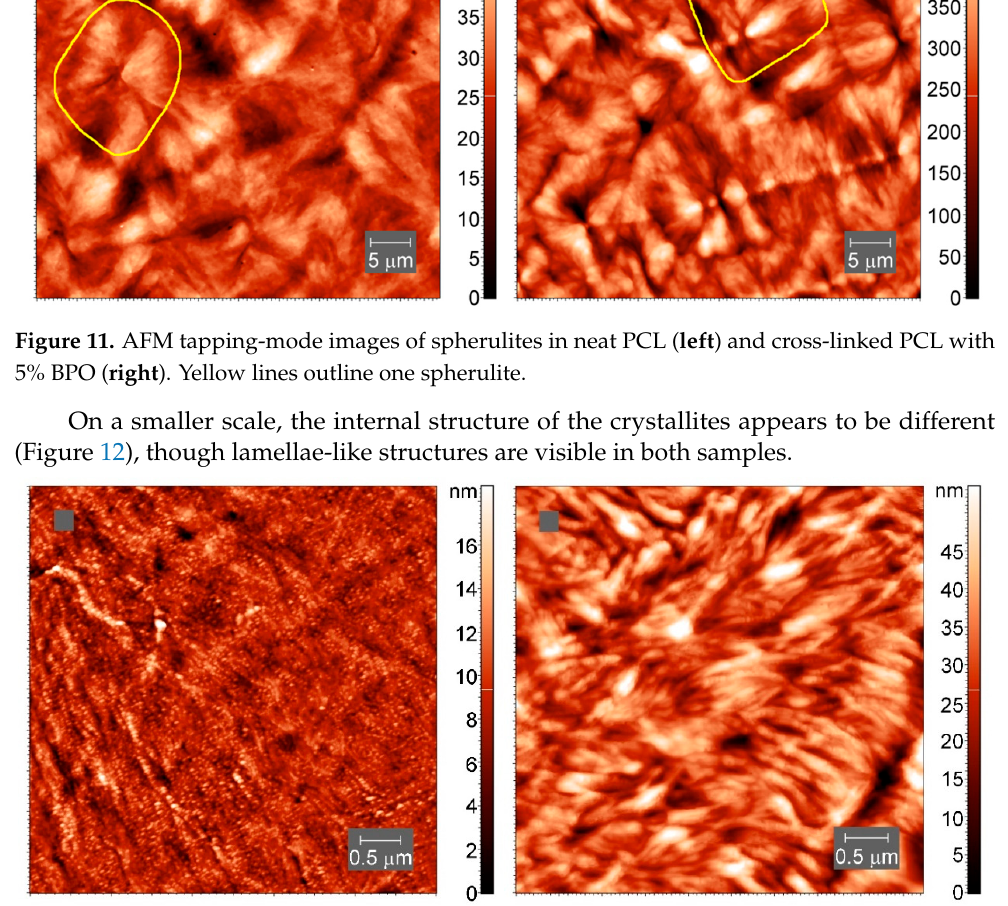
Figure 12. AFM tapping-mode height images of spherulites in neat PCL (left) and cross-linked PCL with 5% BPO (right). The color indicates the height.